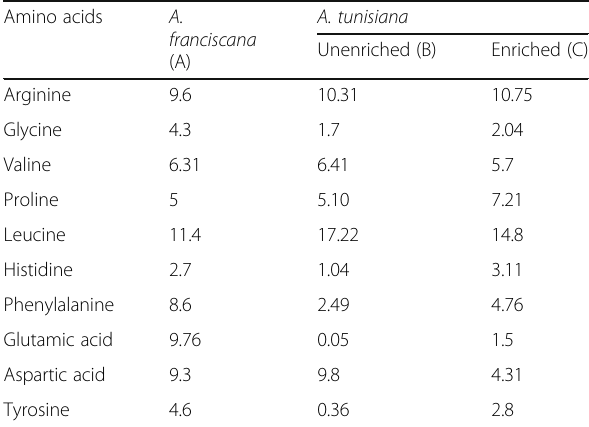
Table 2 Amino acid composition (g amino acids/100 g) (% dry basis) of A. franciscana (A) and unenriched Artemia tunisiana (B), and enriched with HUFA + vitamin C (C) for 24 h